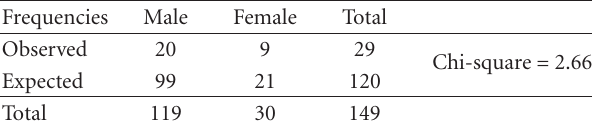
Table 3: The implementation of PD in Adama University when sex is